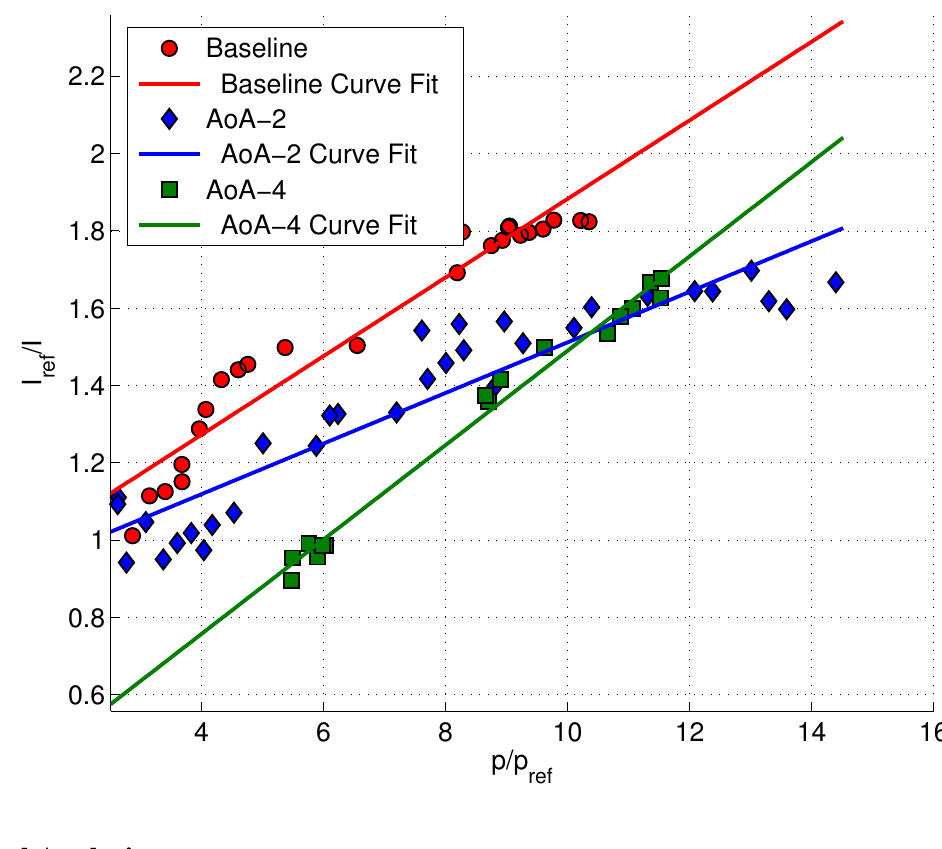
Figure 9. Stern-Volmer calibration plot for sidewall pressure using pressure profile readings obtained on the isolator surface. AoA,